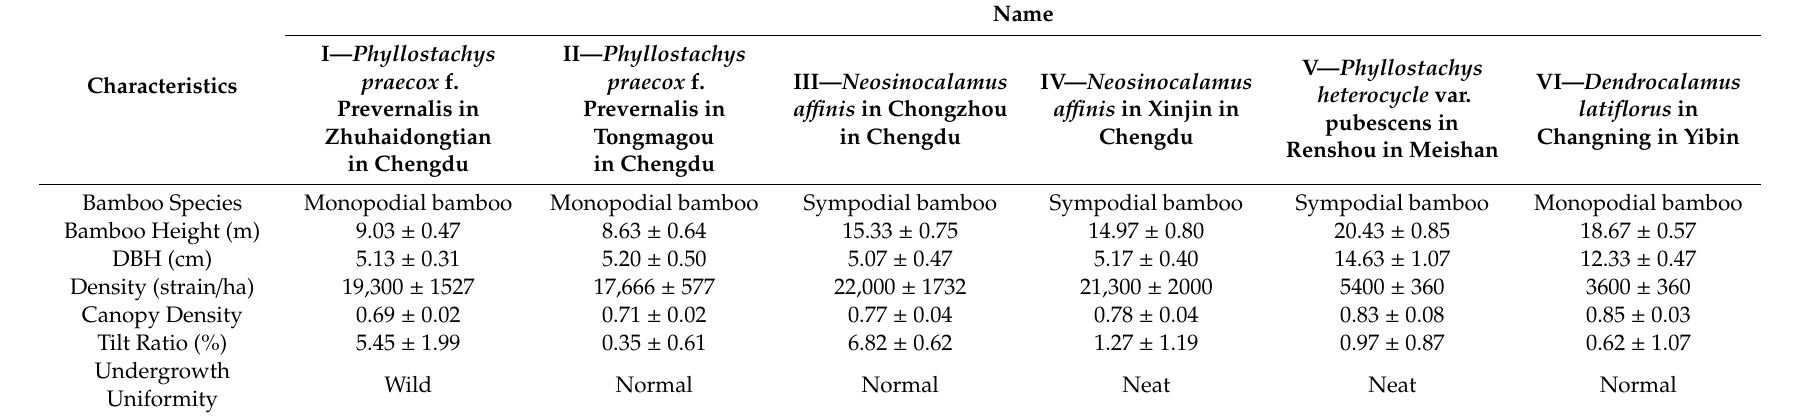
Table 1. The characteristics of six bamboo forests